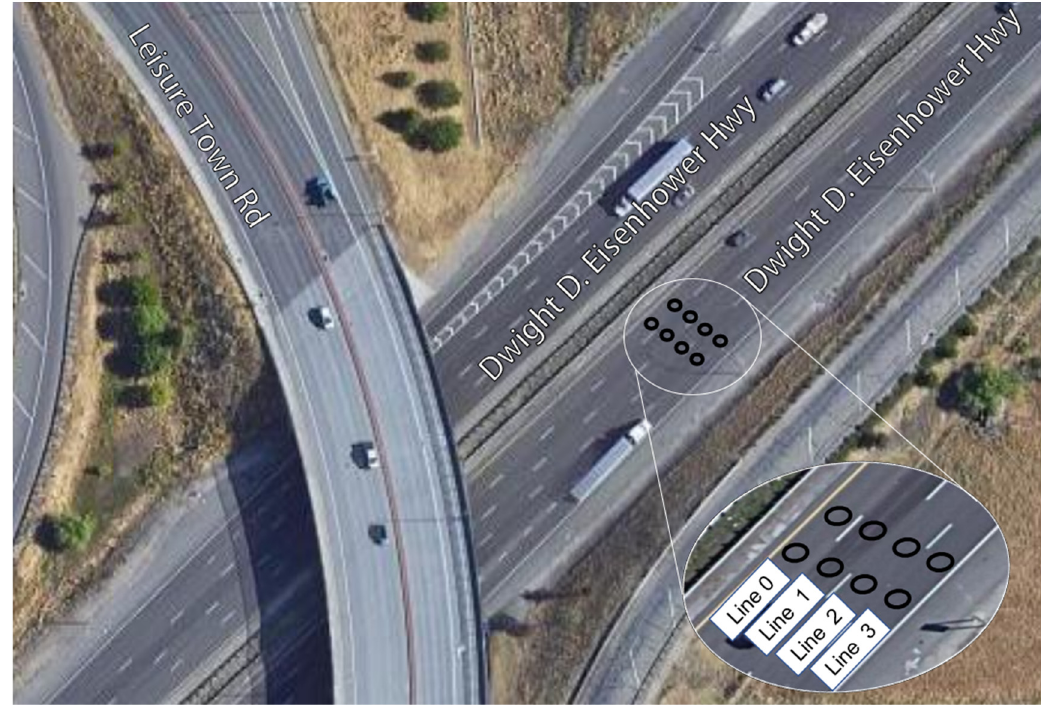
Figure 1. Sensor layout at the mainline traffic survey station.